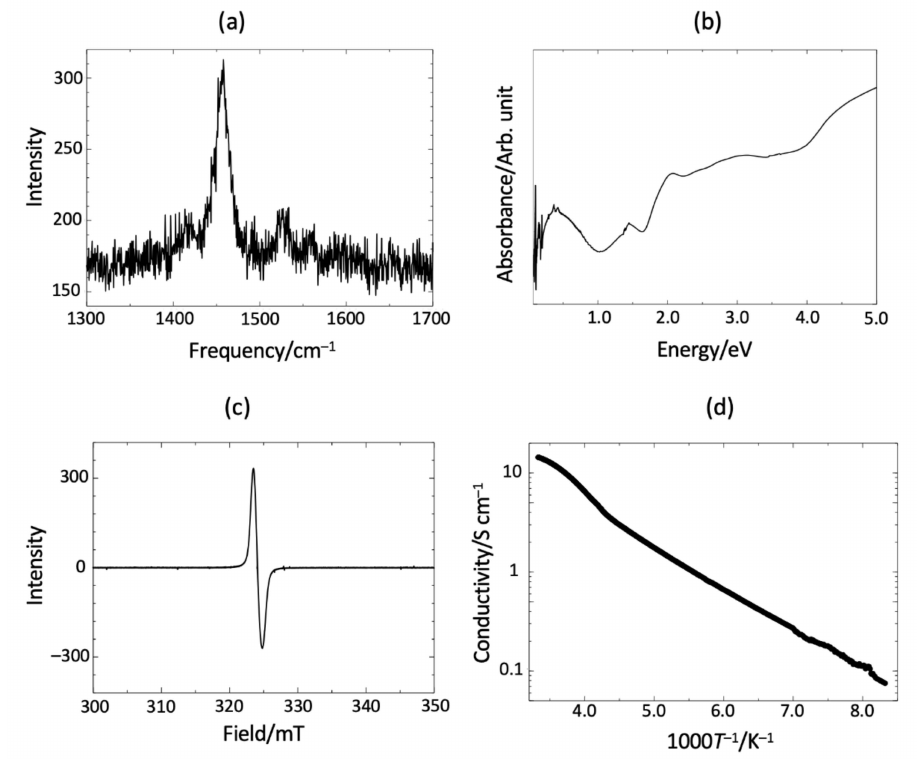
Figure 2. ( a ) Raman spectrum, ( b ) solid-state absorption spectrum from IR to UV energy region, ( c ) ESR spectrum, and ( d ) temperature-dependent electrical conductivity of TTF-py 2 _PF 6. A single crystal direct-current conductivity ( = σ ) of TTF-py 2 _PF 6 along the π -stack direction